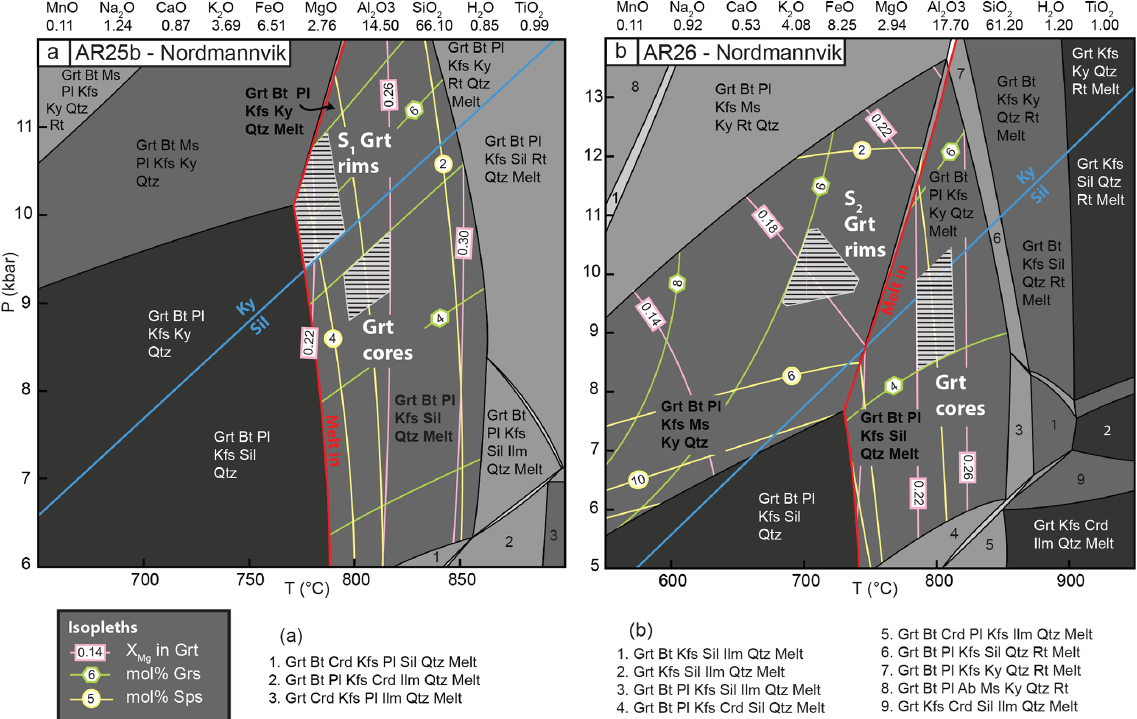
Figure 10. Pseudosections for the Nordmannvik Nappe. (a) Measured garnet core and rim compositions for migmatite (AR25b) agree with modelled compositions that plot above the solidus. Garnet cores give an apparent estimate in the sillimanite stability field. Garnet rims record S 1 foliation-related partial melting in the kyanite stability field. (b) Measured compositions of garnet cores and rims for S 2 mylonitic foliation (AR26) are shown. Garnet cores give an apparent estimate above the solidus in the sillimanite stability field (S 1 foliation – melting). Garnet rims and small garnets give an estimate below the solidus for the S 2